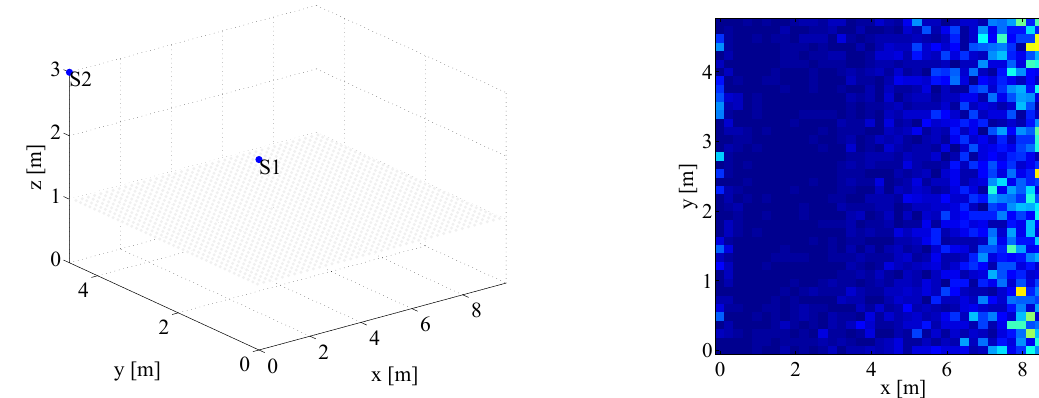
Figure 4. Simulation II: distribution of reconstruction error in the whole room at 1m in height. The unit of the color bar is meters. Receivers are placed along the width of the ceiling and at the corners (left side).